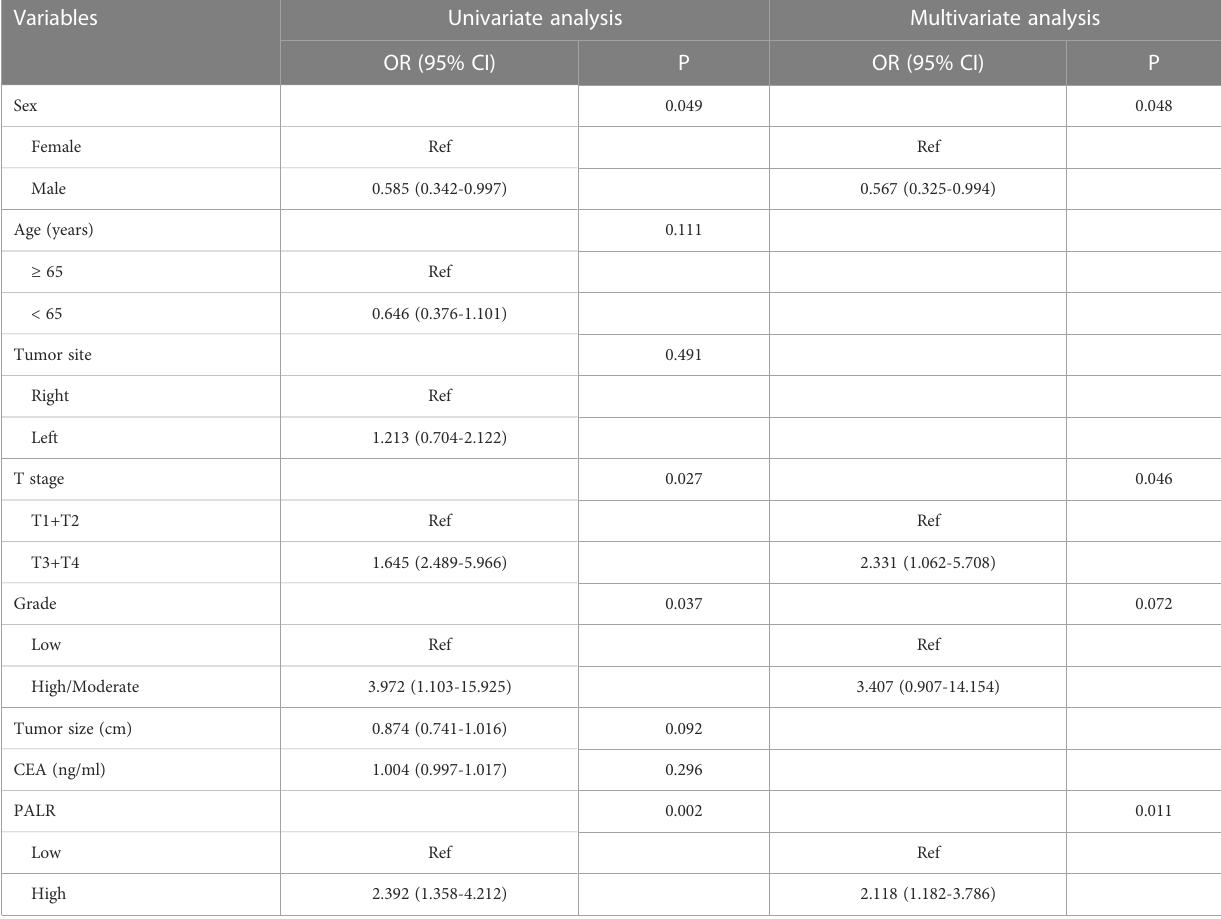
TABLE 2 Logistic analyses the predictors of lymph node metastasis in patients with cN0 colon cancer. Variables